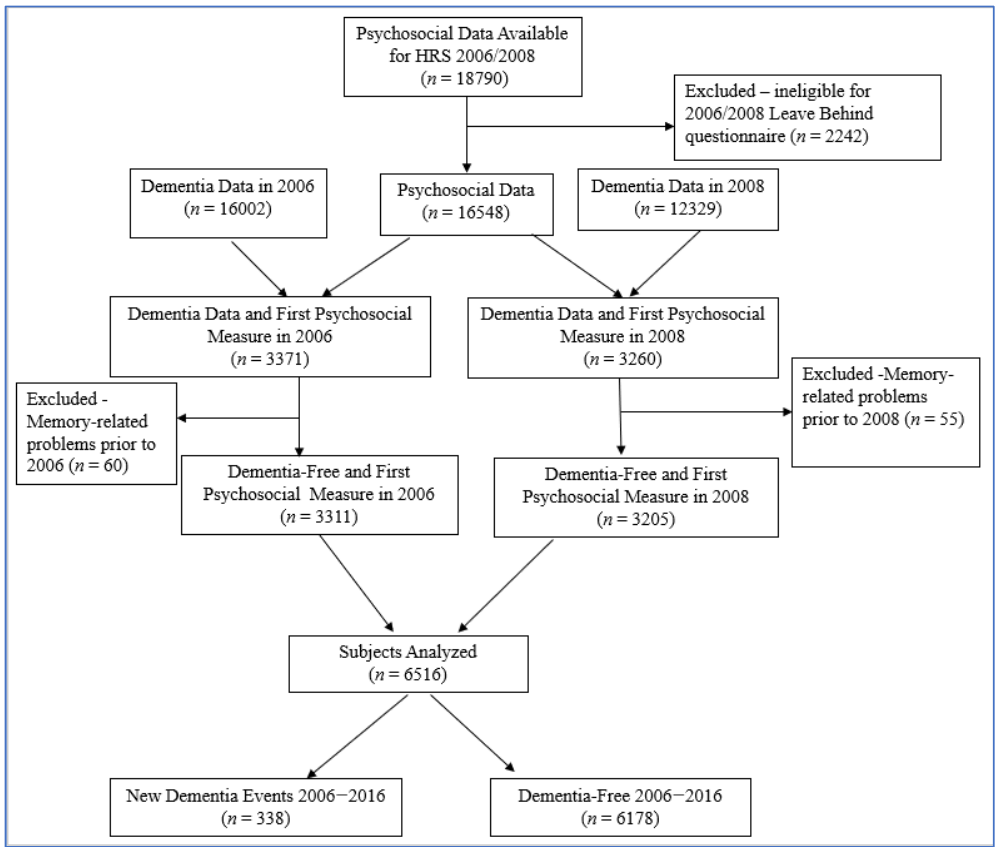
Figure 1. Sample selection to assess the association between Dementia and Psychosocial measures in the Health and Retirement Study, 2006–2016.